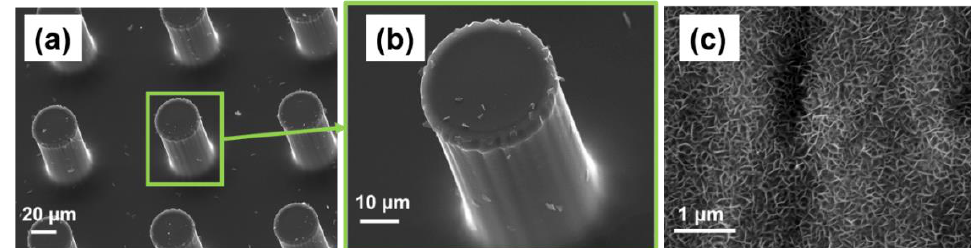
Figure 2. SEM images of ( a ) and ( b ) C-MEMS micro pillars before BPE procedure, ( c ) BPE-rGO deposition on stainless steel control